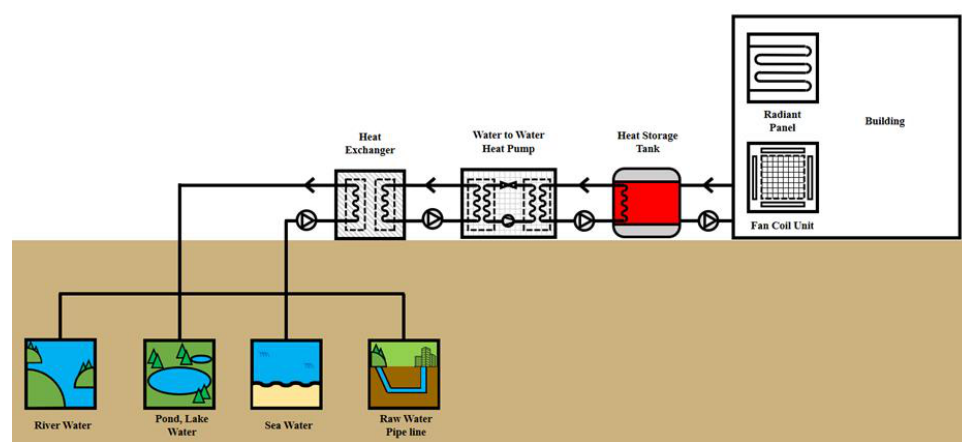
Figure 1. Schematic of natural water source heat pump system.